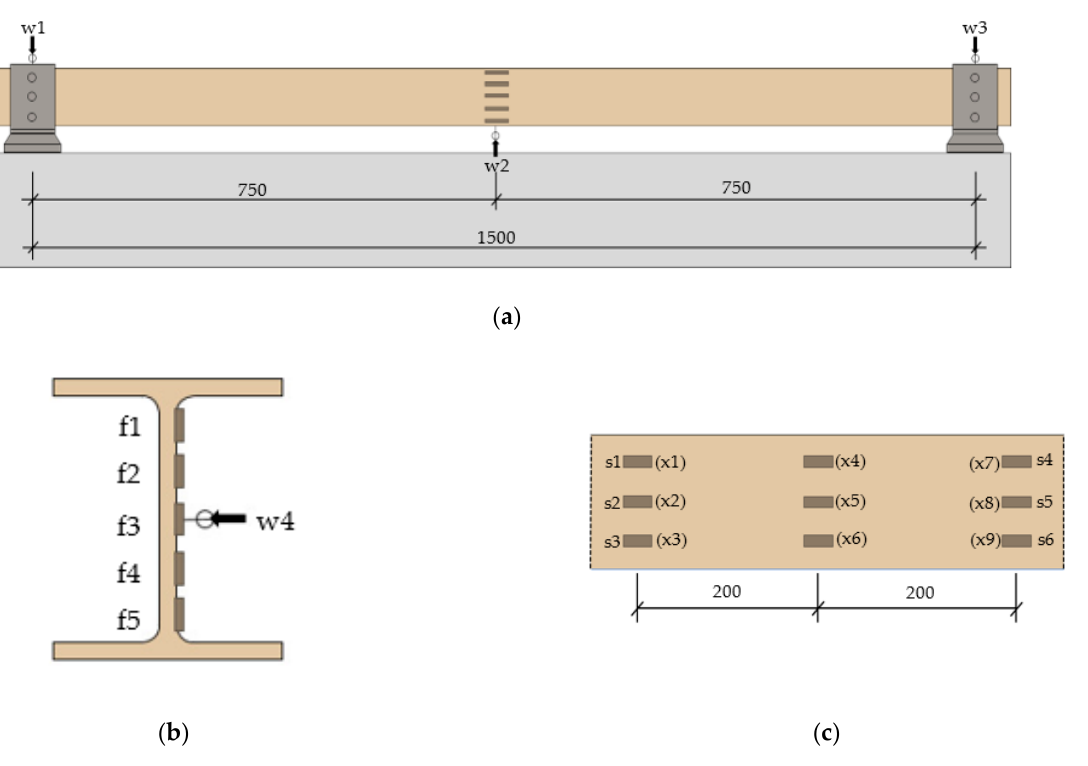
Figure 7. Arrangement of the strain gauges and displacement meters: ( a ) Arrangement of the vertical displacement meters; ( b ) Arrangement of the strain gauges on the webs and the lateral displacement meters; ( c ) Arrangement of the strain gauges on the upper and lower flanges.